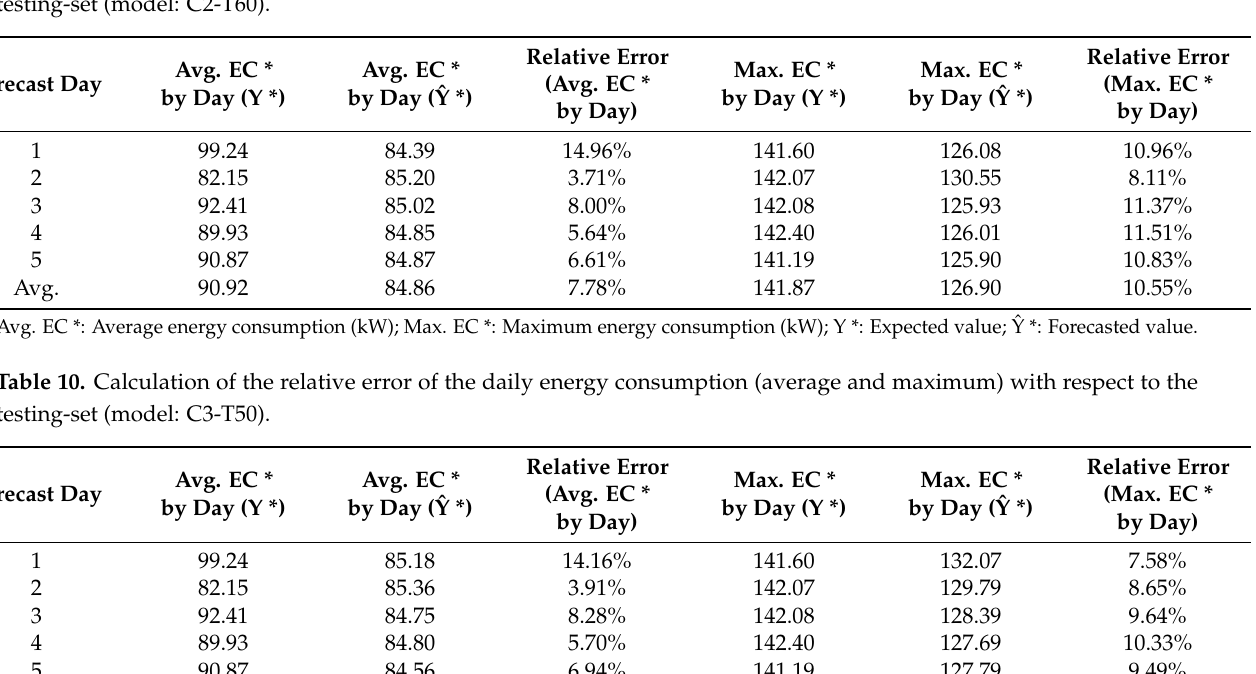
Table 9. Calculation of the relative error of the daily energy consumption (average and maximum) with respect to the testing-set (model: C2-T60).